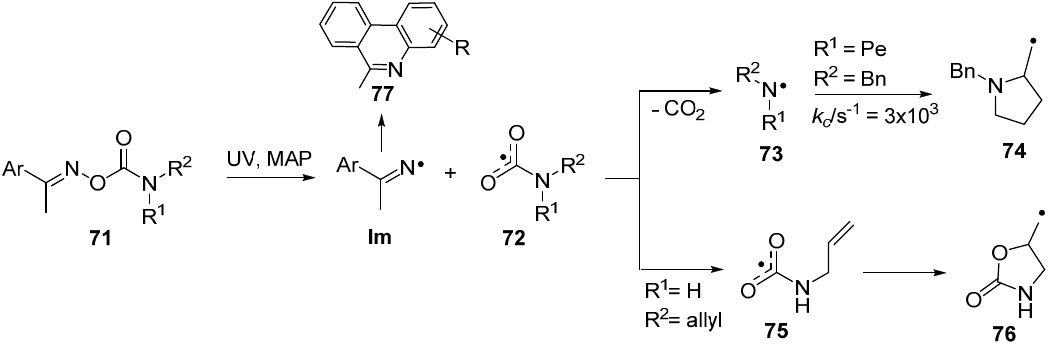
Scheme 11. Photochemical reactions of oxime carbamates [95].